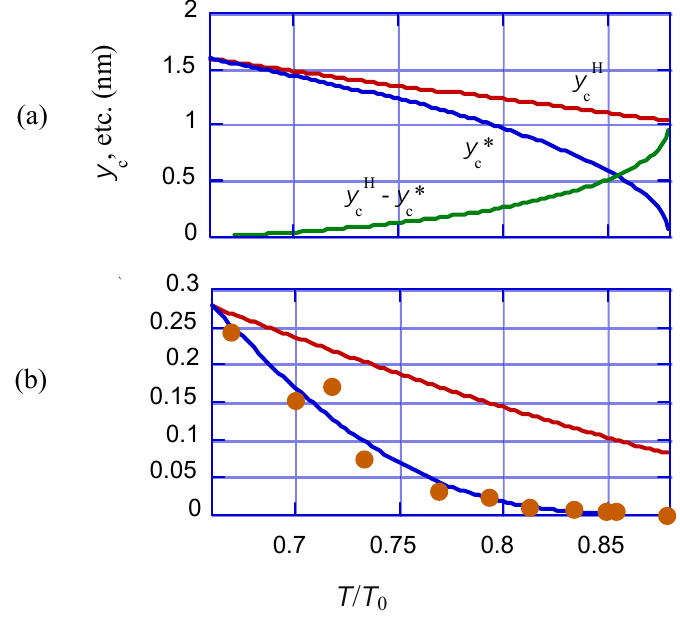
Figure 19. Explanation of the deviation of the force-velocity relation from Hill-type. circles: Experimental data of the sliding velocity per half sarcomere cited from Fig, 3A of the paper by Edman [12]. Red curve: v H , the Hill-type velocity calculated in [2]. Blue curve: v *, transition calculated by Equations 53 and the velocity in the presence of the U * 12